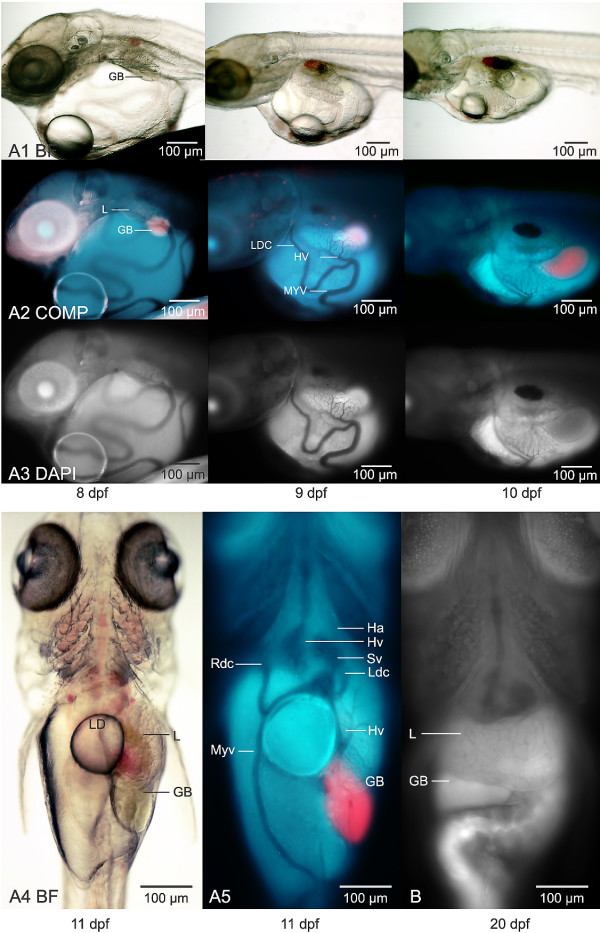
In vivo investigations of hepatobiliary development. (A1 – 1st row) Brightfield microscopy. (A2-2nd row) Composites of DAPI and TRITC image captures, revealing gall bladder (GB) position (red). (A3 – 3rd row) DAPI autofluorescence elucidating vasculature. At day of hatching, 8 dpf, the liver was found as the left lateral longitudinal liver leaflet (L5) phenotype, left lateral and ventral to the 3rd somite (A1 – A3, 1st column). From 8 to 11 dpf the L5 liver and gall bladder descended to the ventral abdomen, with marked restructuring of the visceral and hepatic vasculature. Translocation of the L5 liver and gall bladder to the ventral abdomen (A4, A5) was characterized by: descent of the liver and GB, which remained in a longitudinal position, yolk resorption, the disappearance of the stomatodeal and proctodeal membranes (not shown), the onset of peristalsis, and the beginning of respiration. (A4) Brightfield microscopy, 11 dpf, ventral view, showing liver, gall bladder and lipid droplet. (A5) Widefield fluorescence microscopy, DAPI/TRITC composite, ventral view, elucidating liver, gall bladder and vasculature. The onset of metamorphosis of the hepatobiliary system to a transverse position in the rostral abdominal cavity (adult phenotype) began at 11 dpf. (B) Widefield fluorescence microscopy, DAPI image capture, ventral view. By 20 dpf the liver and gall bladder were transverse in the ventro-rostral abdominal cavity, marking the attainment of the adult phenotype. As can be discerned from the images shown, marked restructuring of the vasculature accompanied metamorphosis of the liver and gall bladder from an embryonic to adult phenotype. While such observations are purely descriptive, they permitted characterization of hallmark events in hepatobiliary development and helped establish normalcy in vivo. Liver (L), Gall Bladder (GB), Heart Atrium (Ha), Heart Ventricle (Hv), Sinus Venosus (Sv), Hepatic Vein (Hv), Left Duct of Cuvier (Ldc), Median Yolk Vein (Myv), Lipid Droplet (LD).